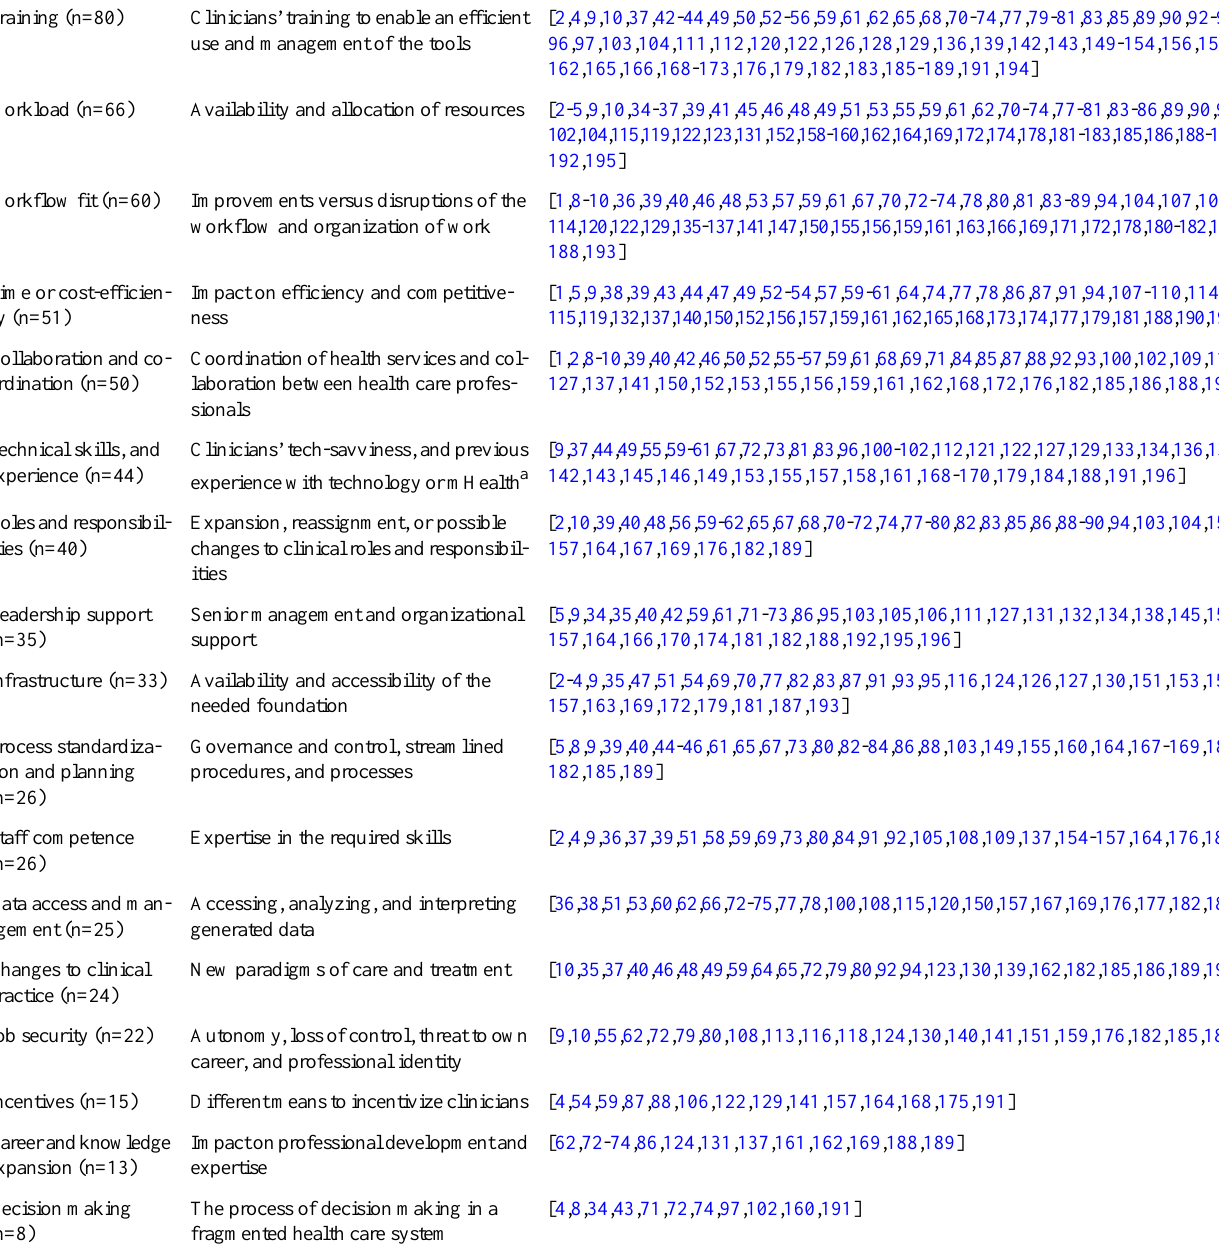
Table 4. Patient-related factors and their occurrence, with